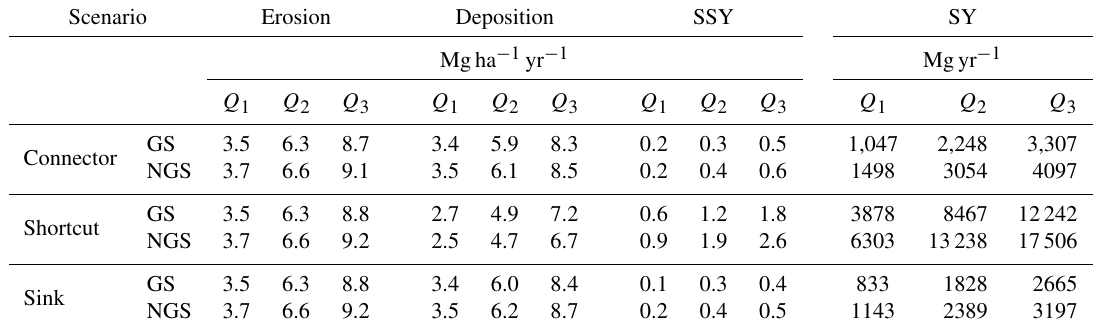
Table 3. Summary statistics of soil redistribution rates and hillslope sediment yields calculated by the WaTEM/SEDEM simulations. Scenario Erosion Deposition SSY